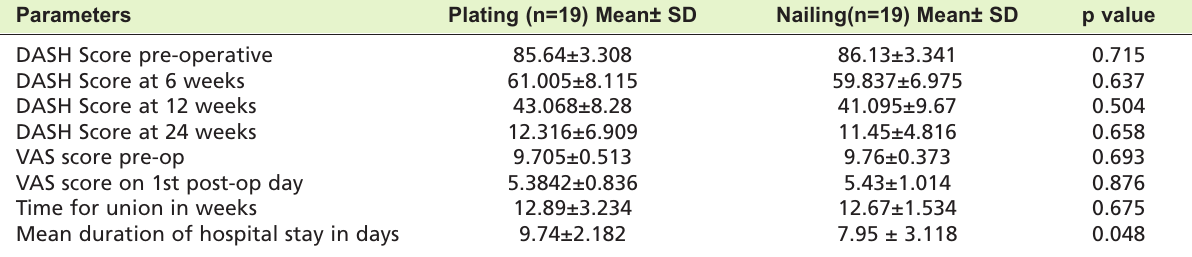
Functional DASH score, VAS score for pain on 1st post-operative day and time taken for union in both the groups Table II: